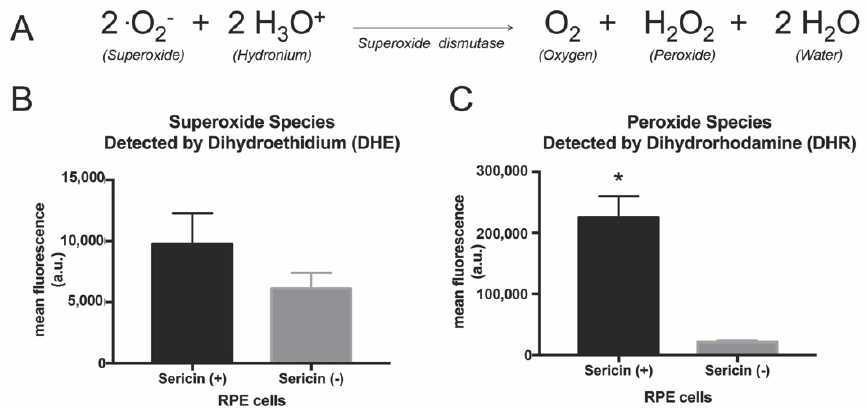
Figure 7. Superoxide dismutase is an antioxidant enzyme that catalyzes the dismutation of superoxide into oxygen, water and hydrogen peroxide ( A ). Proteomic analysis revealed that this enzyme was increased 5.4-fold in cells cultured with sericin compared to cells cultured without sericin. We performed dihydroethidium (DHE) and dihydrorhodamine (DHR) assays to study the levels of the key substrate and product of this enzyme. The DHE assay measures superoxide, while the DHR assay quantifies hydrogen peroxide. The DHE assay revealed no significant increase in superoxide in the sericin-containing RPE cultures compared to control cultures ( B ). The DHR assay showed significantly higher levels of hydrogen peroxide in RPE cultured with sericin ( C ). All bar charts show mean values ± standard deviation error bars. * p < 0.05.